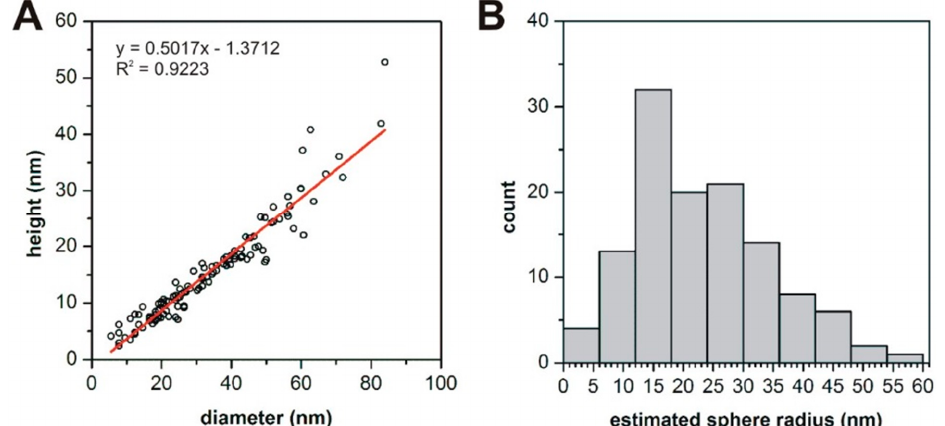
Figure 5. ( A ) Atomic force microscopy (AFM) amplitude-contrast images of surface adsorbed lyophilized oil droplets. ( B ) The area marked by dashed line is shown. ( C ) Height distribution of droplets (n = 122).